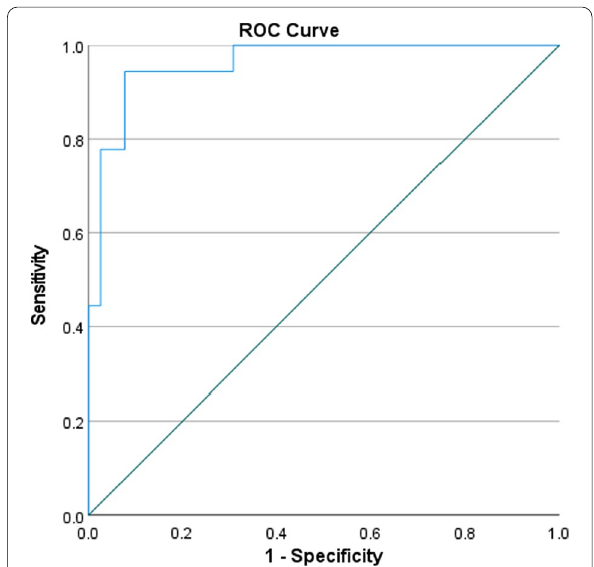
Fig. 2 ROC curve to decide LDH level to discriminate between deceased versus recovered. It shows LDH cut-off value > 512 had 94% sensitivity and 93% specificity for the mortality showing the cut-off > 512 LDH value discriminate accurately 96% (95% CI: 92% to 100%) between deceased and recovered patients